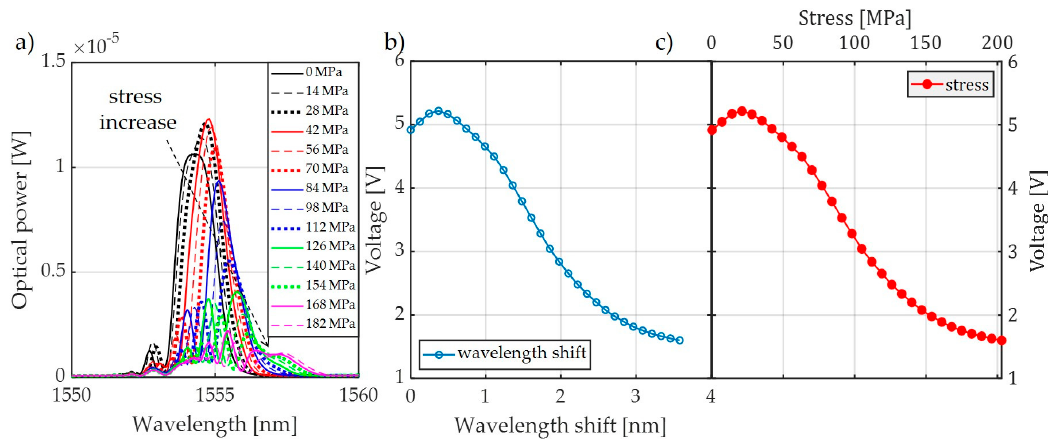
Figure 14. Measurement results in the interrogator system shown in Figure 9 for the FBG + FBGF2 matched gratings pair: ( a ) change in the shape of the system output signal due to stress change; ( b ) conversion characteristics of the wavelength shift into a voltage change measured on the photodetector; ( c ) the characteristics of the power line conductor stress conversion to changes in the voltage on the photodetector.